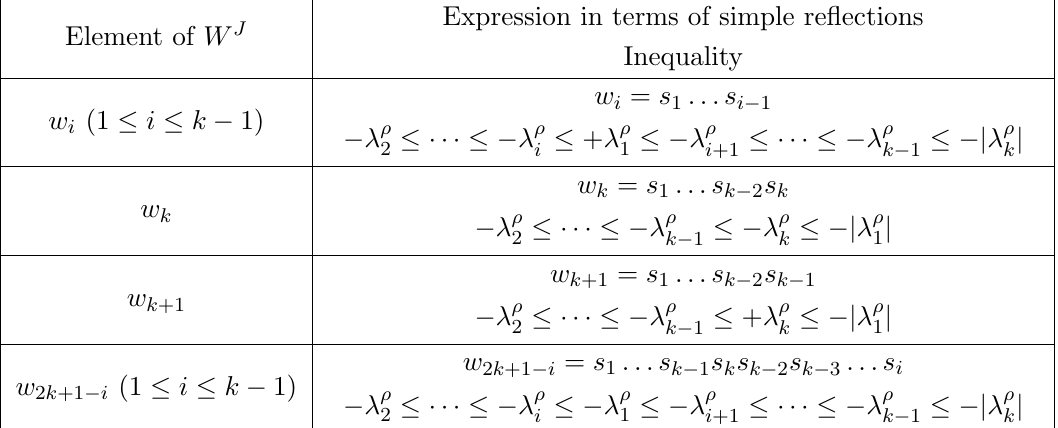
(cid:20) (cid:1) (cid:1) (cid:1) (cid:20) (cid:21) (cid:26) (cid:20) (cid:0)j (cid:21) (cid:26) j . 1 k (cid:0) 1 k